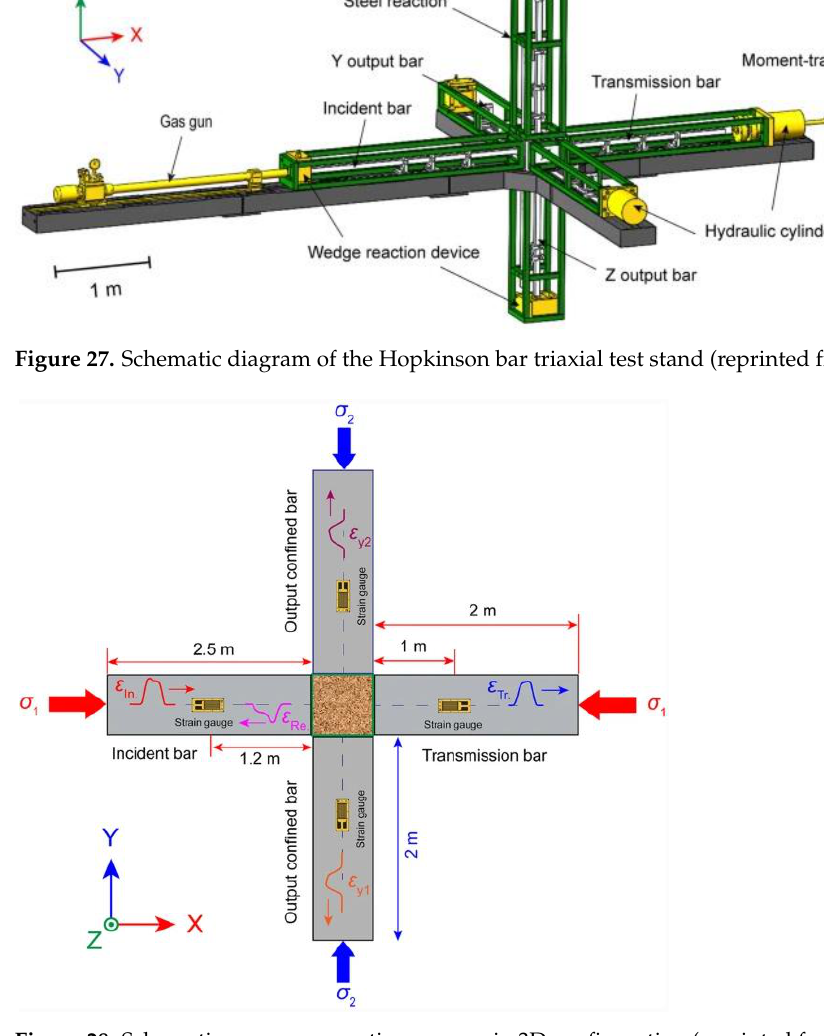
Figure 28. Schematic wave propagation process in 3D configuration (reprinted from Ref. [93]).